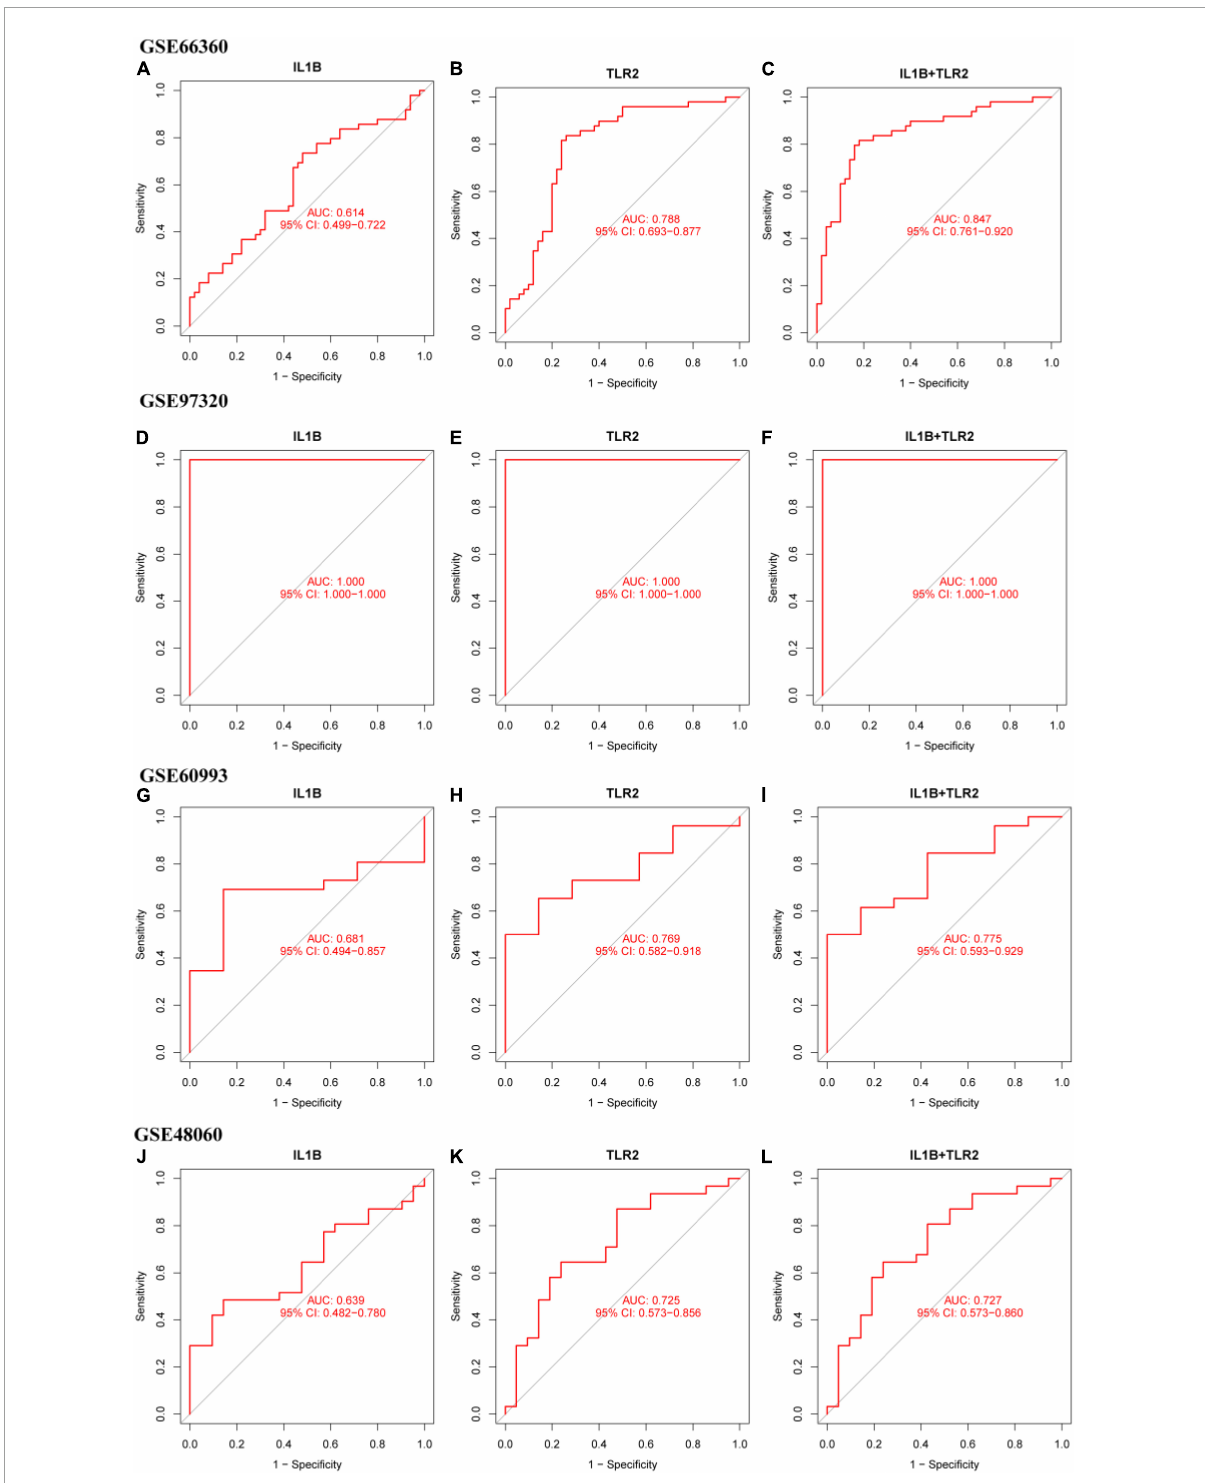
FIGURE7 The ROC curve of the diagnostic efficiency of IL1B, TLR2, and IL1B + TLR2. (A) ROC curve of IL1B in the GSE66360. (B) ROC curve of TLR2 in the GSE66360. (C) ROC curve of IL1B + TLR2 in the GSE66360. (D) ROC curve of IL1B in the GSE97320. (E) ROC curve of TLR2 in the GSE97320. (F) ROC curve of IL1B + TLR2 in the GSE97320. (G) ROC curve of IL1B in the GSE60993. (H) ROC curve of TLR2 in the GSE60993. (I) ROC curve of IL1B + TLR2 in the GSE60993. (J) ROC curve of IL1B in the GSE48060. (K) ROC curve of TLR2 in the GSE48060. (L) ROC curve of IL1B + TLR2 in the